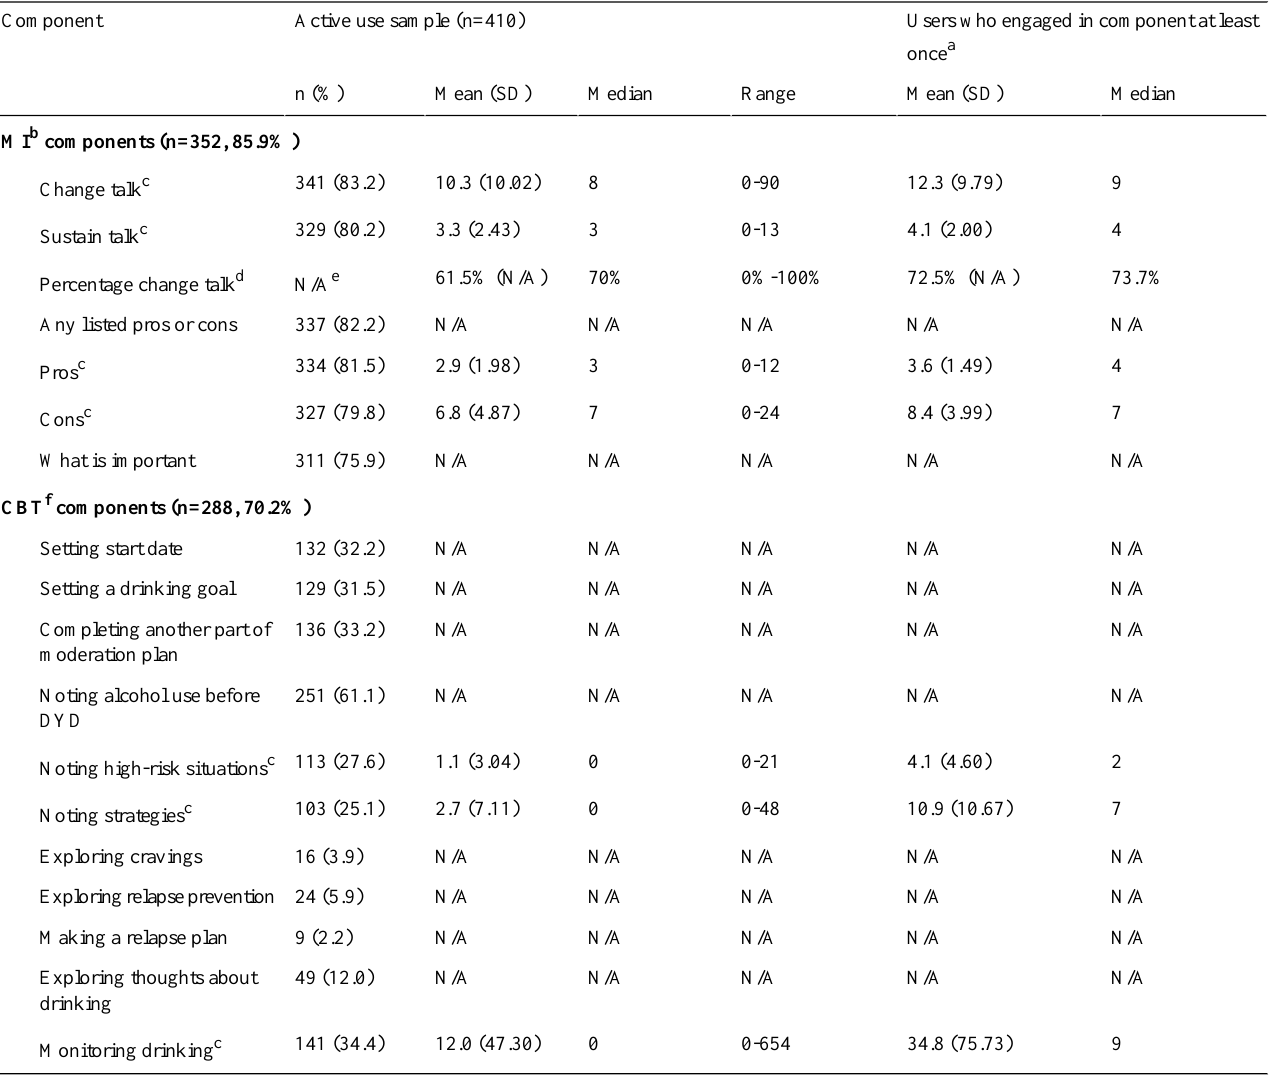
Active use sample (n=410)Component